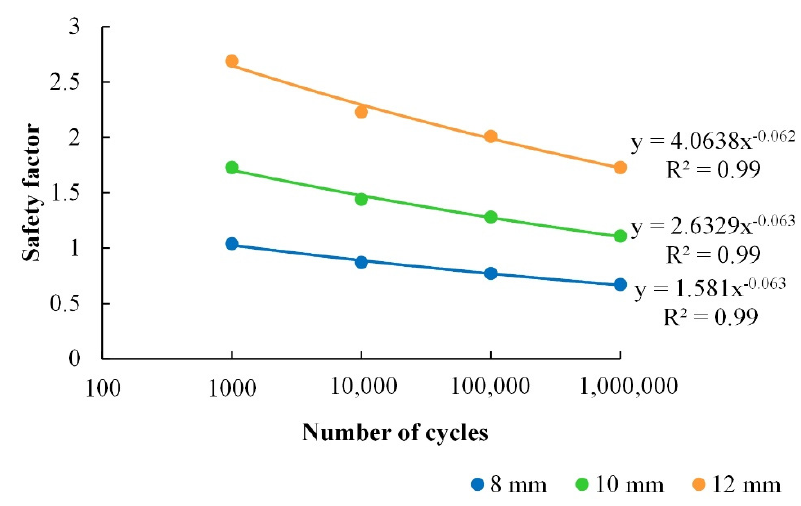
Figure 9. Results of the fatigue analysis of the spike segment (semilogarithmic scale).